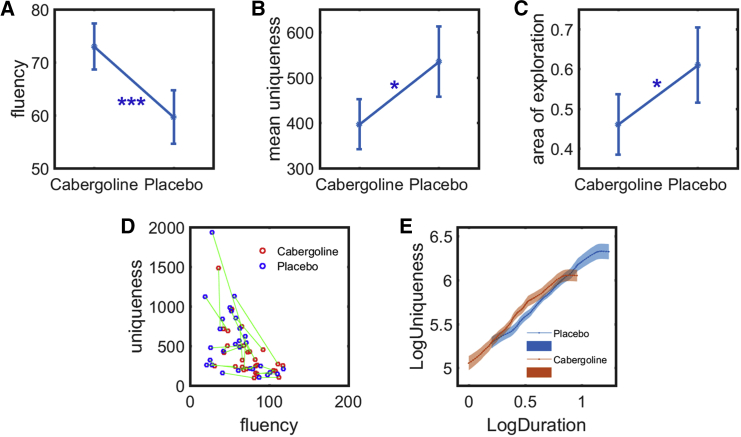
Option-Generation Task Performance in Healthy Elderly People (n = 29) on Cabergoline and Placebo (Study 3)(A–C) Healthy people generated significantly more path options when they have taken cabergoline (dopamine D2 agonist) compared to placebo (p < 0.001) (A). Yet they were more unique (p < 0.05) (B) and explored a larger area in the 2-dimensional path subspace (p < 0.05) (C) when they were on placebo.(D) A scatterplot of each individual’s mean uniqueness of paths against their number of paths generated. The same individual when on cabergoline and placebo are connected by green lines.(E) A mixed model applied to account for the correlation between fluency and uniqueness found that dopamine increases the uniqueness of paths for a given fluency (p < 0.001), which is consistent with what we have found from Parkinson’s disease patients in study 2. This increase is stronger in apathetic individuals.Error bars refer to one SE. See also Figures S2, S3, S4, and S7.